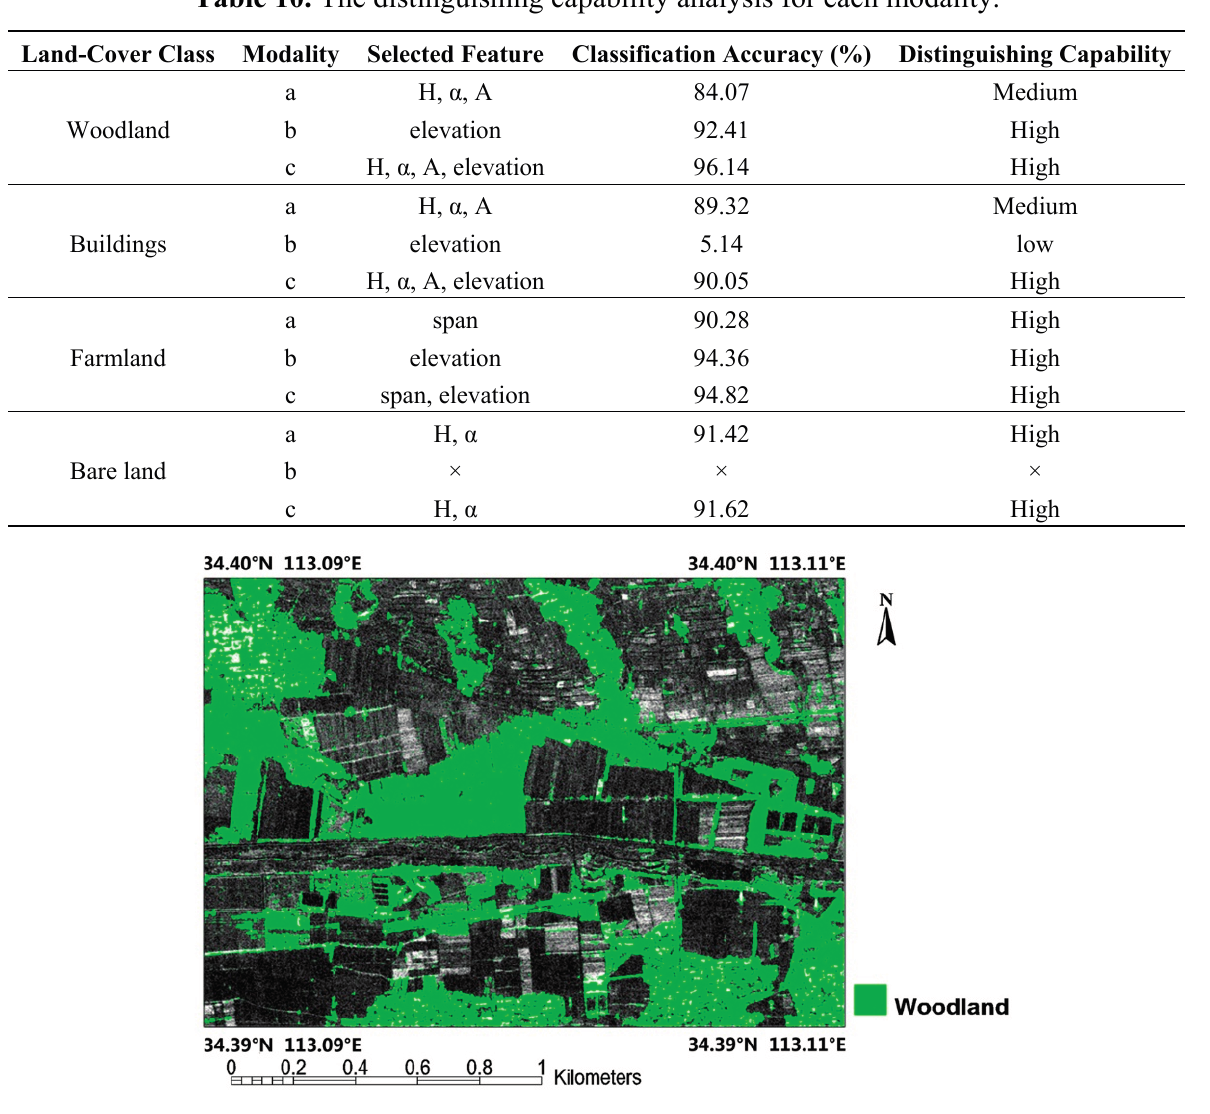
Figure 10. The extracted woodland map of the study